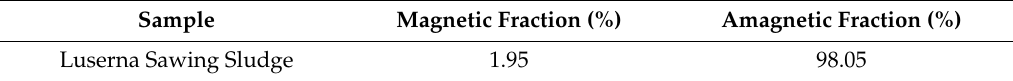
Table 3. Results of magnetic separation on Luserna sawing sludge